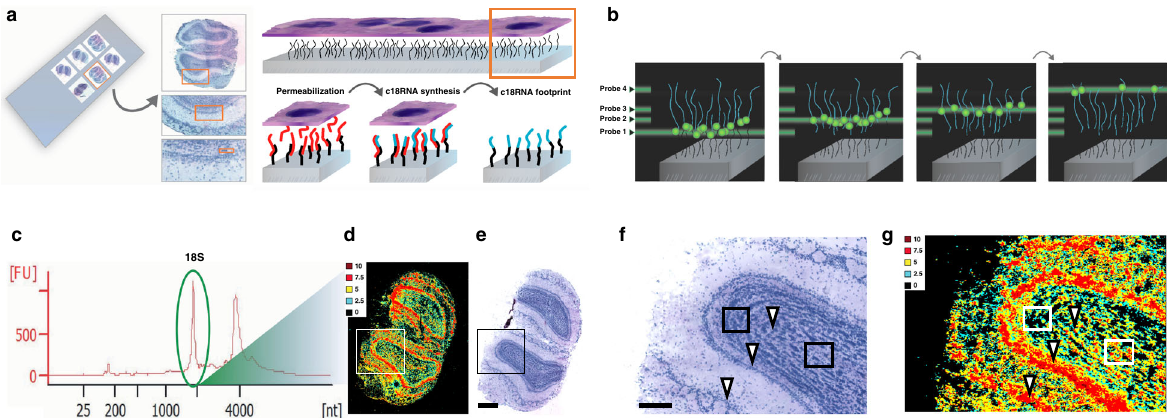
Fig. 1 The spatial RNA Integrity Number (sRIN) assay. a Schematics of an one cell layer thick tissue section placed on a pre-printed fully coated capture area for 18S rRNA, leading to the formation of a c18RNA-footprint. b Schematic depiction of the sequential probe hybridization. c Total RNA gel electropherogram of a mouse olfactory bulb tissue sample together with d a heat map visualization of the section ’ s spatial RNA integrity number (sRIN) distribution based on its c18RNA footprint ( n = 4, technical replicates) and e a HE image of the same section (scale bar: 600 µ m), boxes enclose regions shown in close-up. f Close-up of HE image (scale bar: 200 µ m) and g sRIN heat map, arrows marks cells from different areas in the tissue with high sRIN values, the left box depicts a group of cells where cell drop-out has occurred compared to the right box that depicts a group of cells recording high sRIN